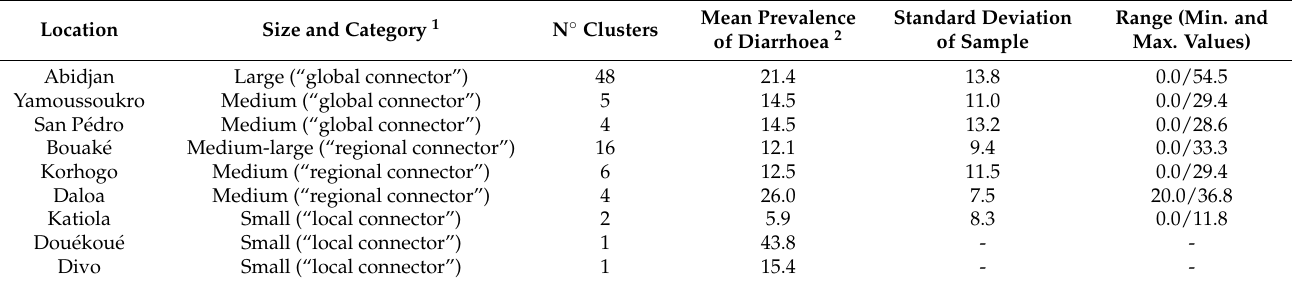
Table A2. Observed prevalence of diarrhoea among children under five in a selection of Ivoirian